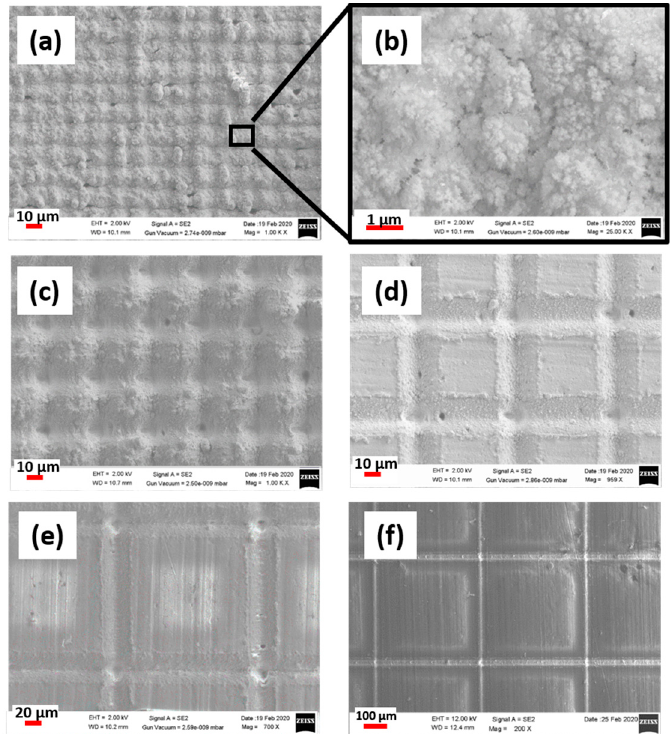
Figure 2. SEM pictures of laser-textured surfaces. The hatch distance between consecutive scanning lines are: ( a , b ) 10 µm (two different magnifications), ( c ) 50 µm, ( d ) 100 µm, ( e ) 200 µm and ( f ) 500 µm. lines are: ( a , b ) 10 µ m (two di ff erent magnifications), ( c ) 50 µ m, ( d ) 100 µ m, ( e ) 200 µ m and ( f ) 500 µ